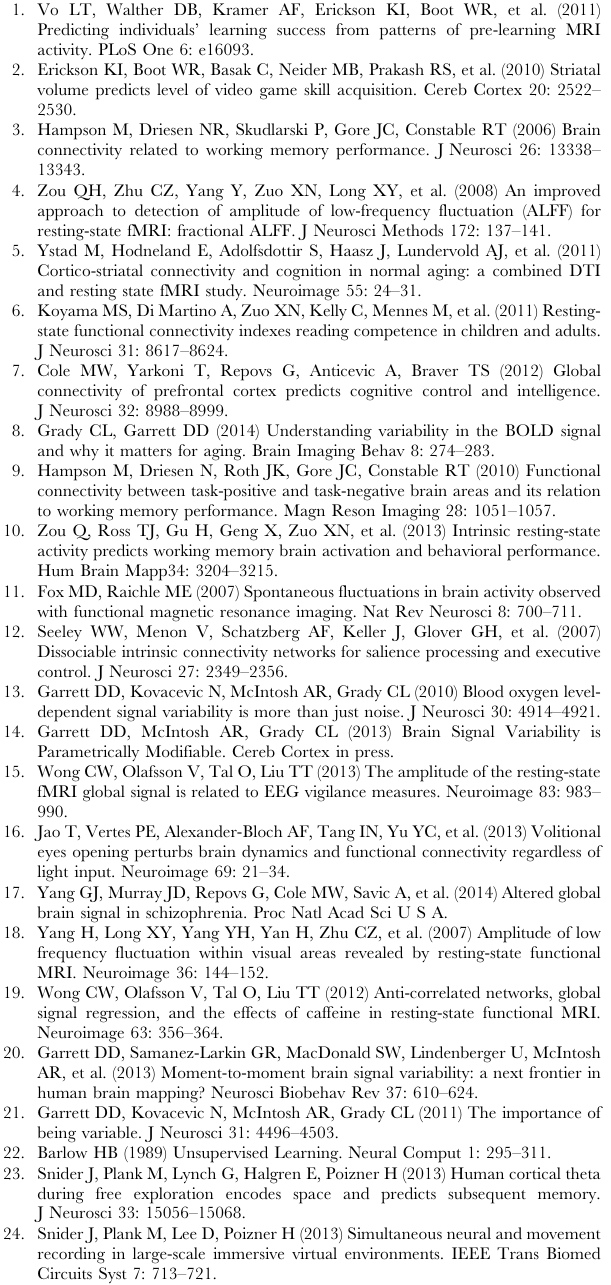
Figure S1 Whole brain map showing correlation values between the BOLD signal variability and performance scores across subjects (p , 0.05, corrected for multiple comparisons using AlphaSim in AFNI, minimum cluster size =258 voxels).